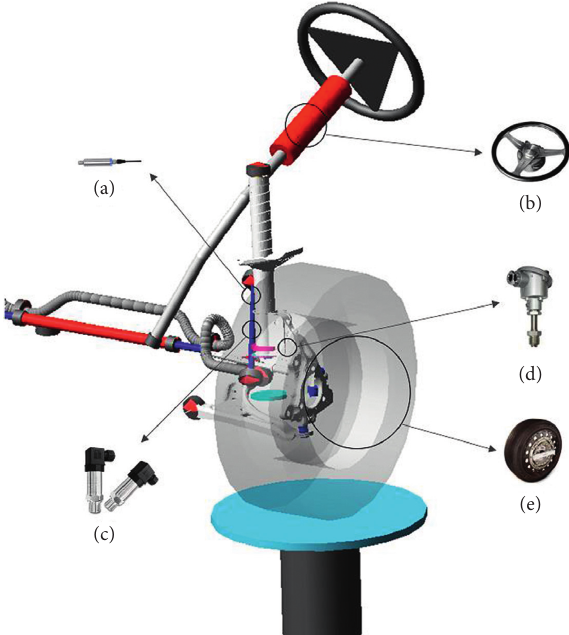
Figure 3: Schematic of sensor arrangement. (a) Sound pressure sensor. (b) Steering angle sensor. (c) Oil pressure sensor. (d) Temperature sensor. (e) Six-dimensional wheel force